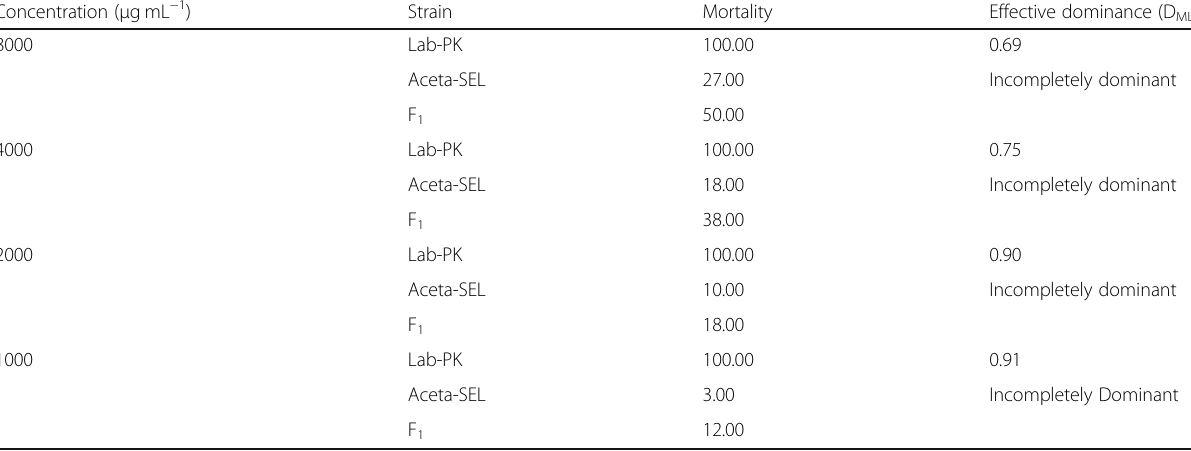
Table 3 Effective dominance ( D ML ) of acetamiprid resistance in Aceta-SEL strain of Chrysoperla